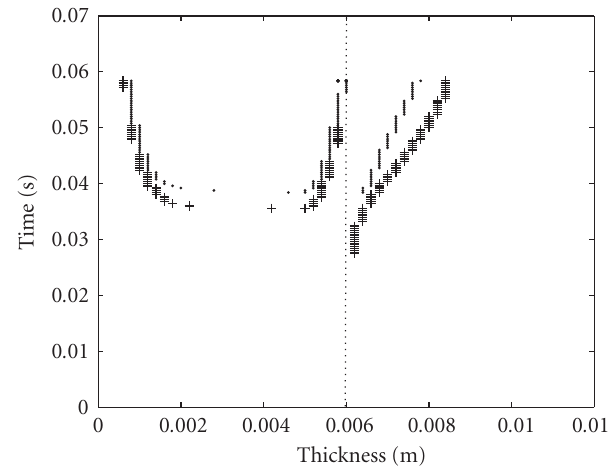
Figure 4.11. Example 4: the mushy (+ signs) and molten (other signs) regions in the steel (left of the broken line) and the aluminum (right of the broken line)